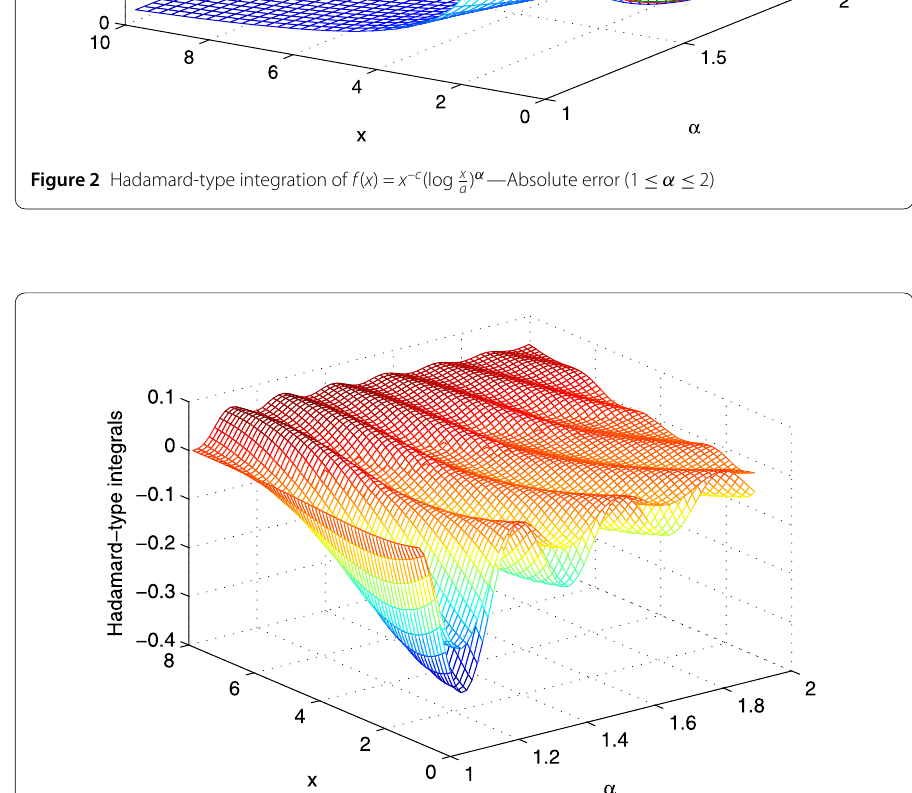
Figure 3 Hadamard-type fractional integrals of g ( x ) = x α – c sin(3 α x ) for c = 1 and c =